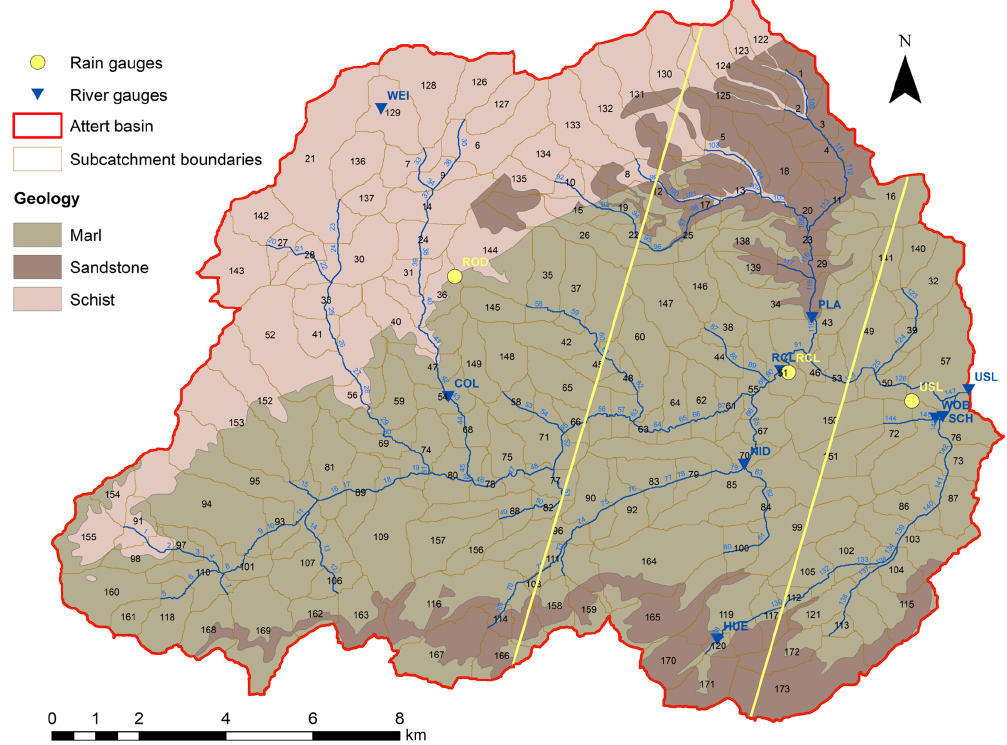
Figure 2. Map of the Attert basin up to the Useldange gauge. Black labels are the simple hydrological model (SHM) subcatchment IDs, and blue labels are SHM river element IDs. Yellow and blue labels are rain and river gauge IDs, respectively. The yellow lines indicate the area of influence of each rain gauge as determined by the nearest-neighbour method. Further information about the gauges and the SHM model is given in Sects. A1–A3 of the